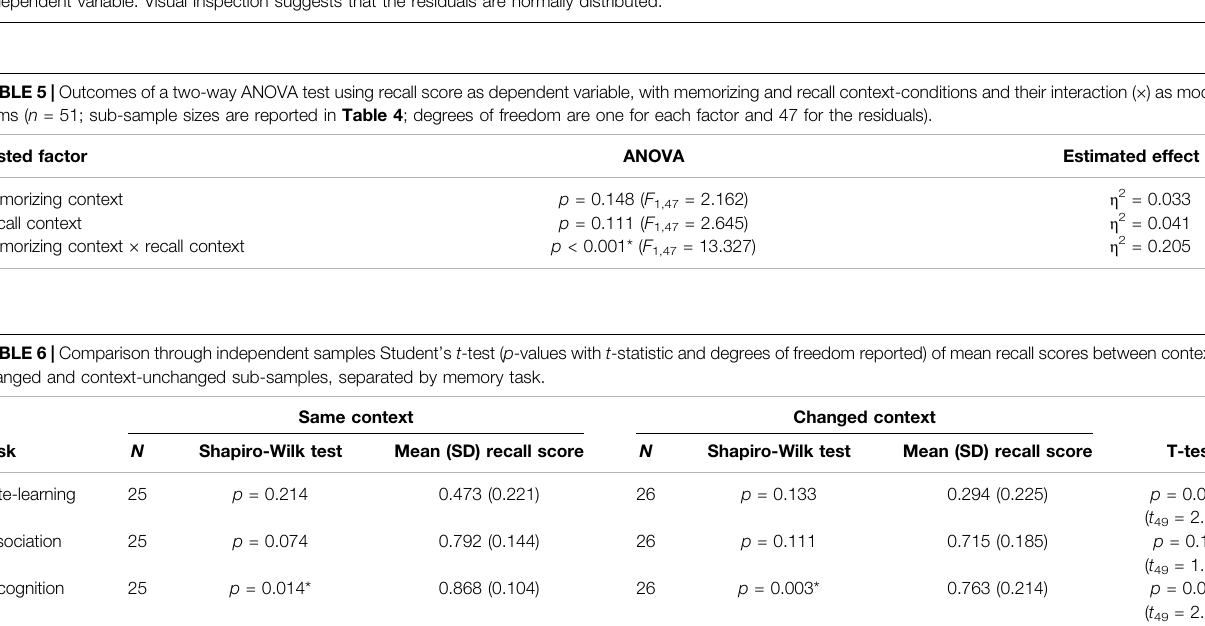
FIGURE 6 | Q-Q plot of the residuals ( n (cid:1) 51) from a two-way ANOVA test using memorizing and recall context-conditions as fi xed factors and recall score as dependent variable. Visual inspection suggests that the residuals are normally distributed.